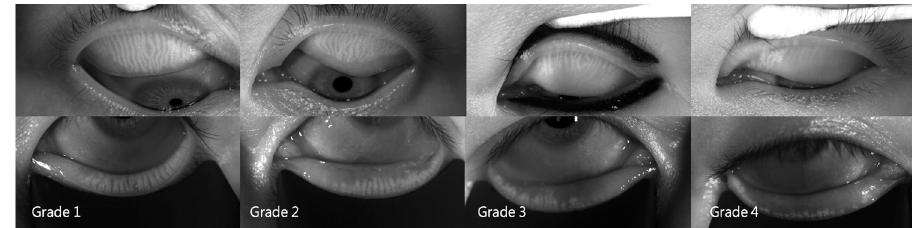
Figure 2. Representative meibography images of the four meiboscale grades.